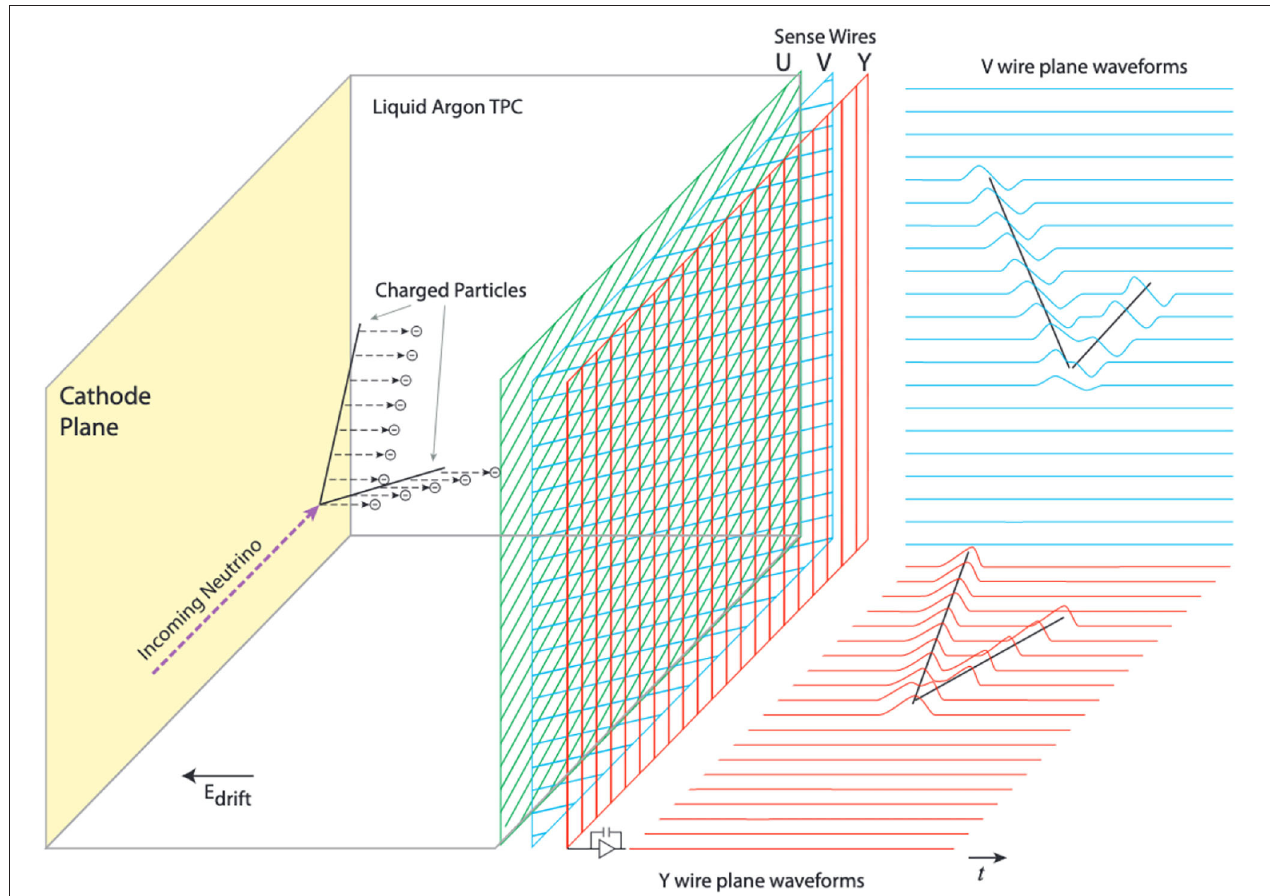
FIGURE 1 | Operating principle of a LArTPC. The ionization electrons are drifted toward sensor arrays, e.g., planes of ionization charge sensor wires. Each wire is connected to an analog amplifier/shaper, followed by an ADC, and its resulting digital waveform is read out continually. Waveforms of adjacent wires appended together form 2D images. Image credit: Acciarri et al.